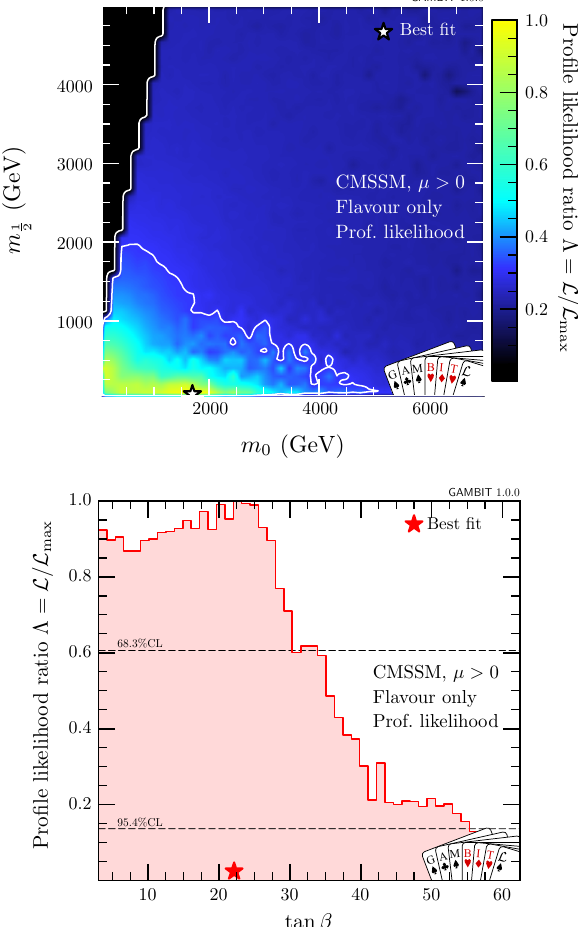
Fig. 1 2D (upper) and 1D (lower) profile likelihoods of Lagrangian parameters m 0 , m 1 / 2 and tan β in a CMSSM fit including flavour and nuisance likelihoods only. Stars identify the best fit, and contours indi- cate 1 and 2 σ confidence regions. The jagged edge of the 2 σ contour at low m 0 and large m 1 / 2 is a plotting artefact, caused by interaction of the binning required for plotting and the abruptness of the dropoff of the likelihood in this region (due to the requirement that the lightest supersymmetric particle be a